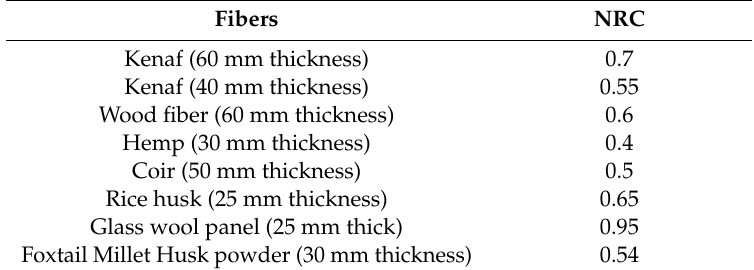
Table 6. Noise reduction coe ffi cient (NRC) values of other natural fibers, glass wool and